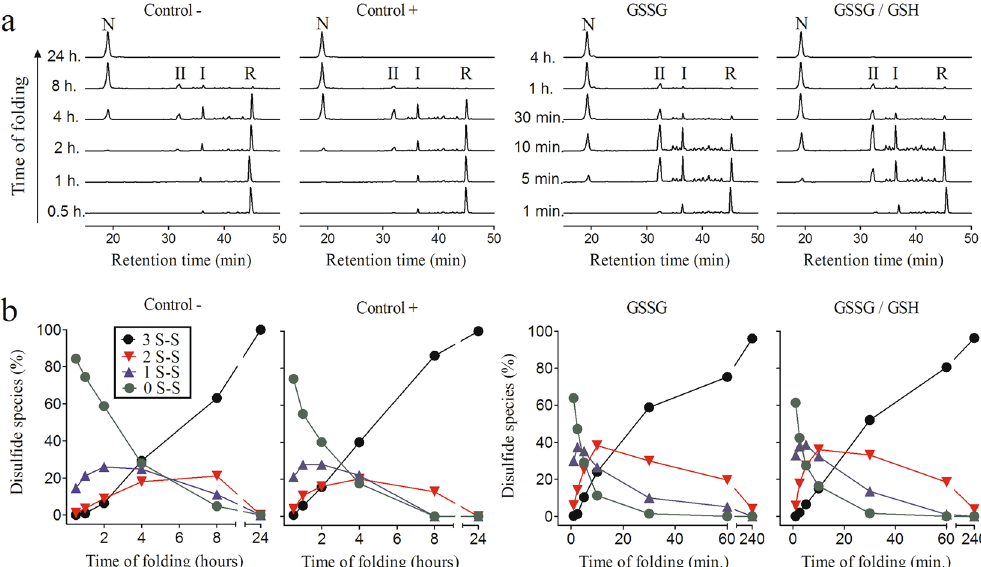
Figure 2. RP-HPLC analysis of the folding intermediates and quantitative analysis of disulfide species along the oxidative folding pathway of NvCI. Folding was carried out in Tris-HCl buffer (pH 8.4) in the absence (Control − ) and presence of selected redox agents: 0.25 mM 2-mercaptoethanol (Control + ), 0.5 mM GSSG or a mixture of 0.5 mM GSSG and 1 mM GSH. ( a ) Chromatographic profiles of the folding reactions. Intermediates were acid-trapped at the noted times and analyzed by RP-HPLC. Retention times of the native (N) and fully reduced/unfolded (R) forms as well as the two major intermediates (I and II) are indicated. ( b ) Disulfide species in the oxidative folding of NvCI. Intermediates were trapped by alkylation of the free cysteines at various times and analyzed by MALDI-TOF-MS. 0S-S, 1S-S, 2S-S, and 3S-S represent the completely reduced, one disulfide, two disulfide, and three disulfide species,